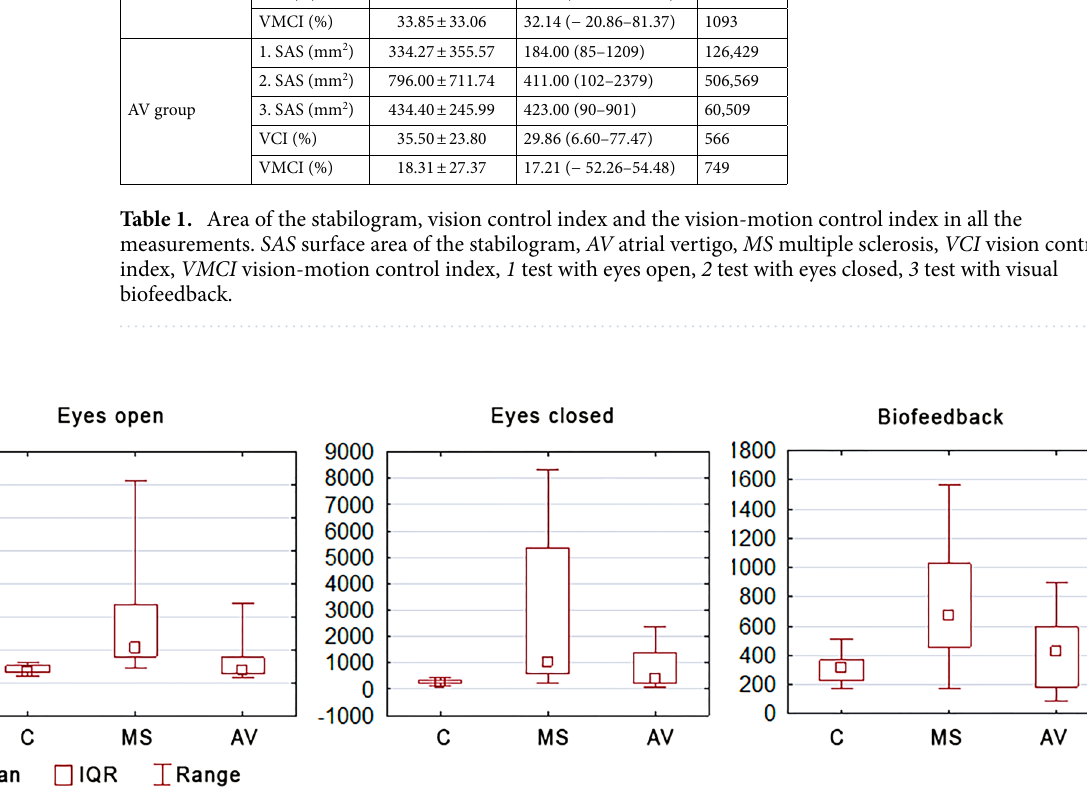
Figure 2. Comparison of the sizes of stabilogram surface areas between groups. C control group, MS multiple sclerosis group, AV atrial vertigo